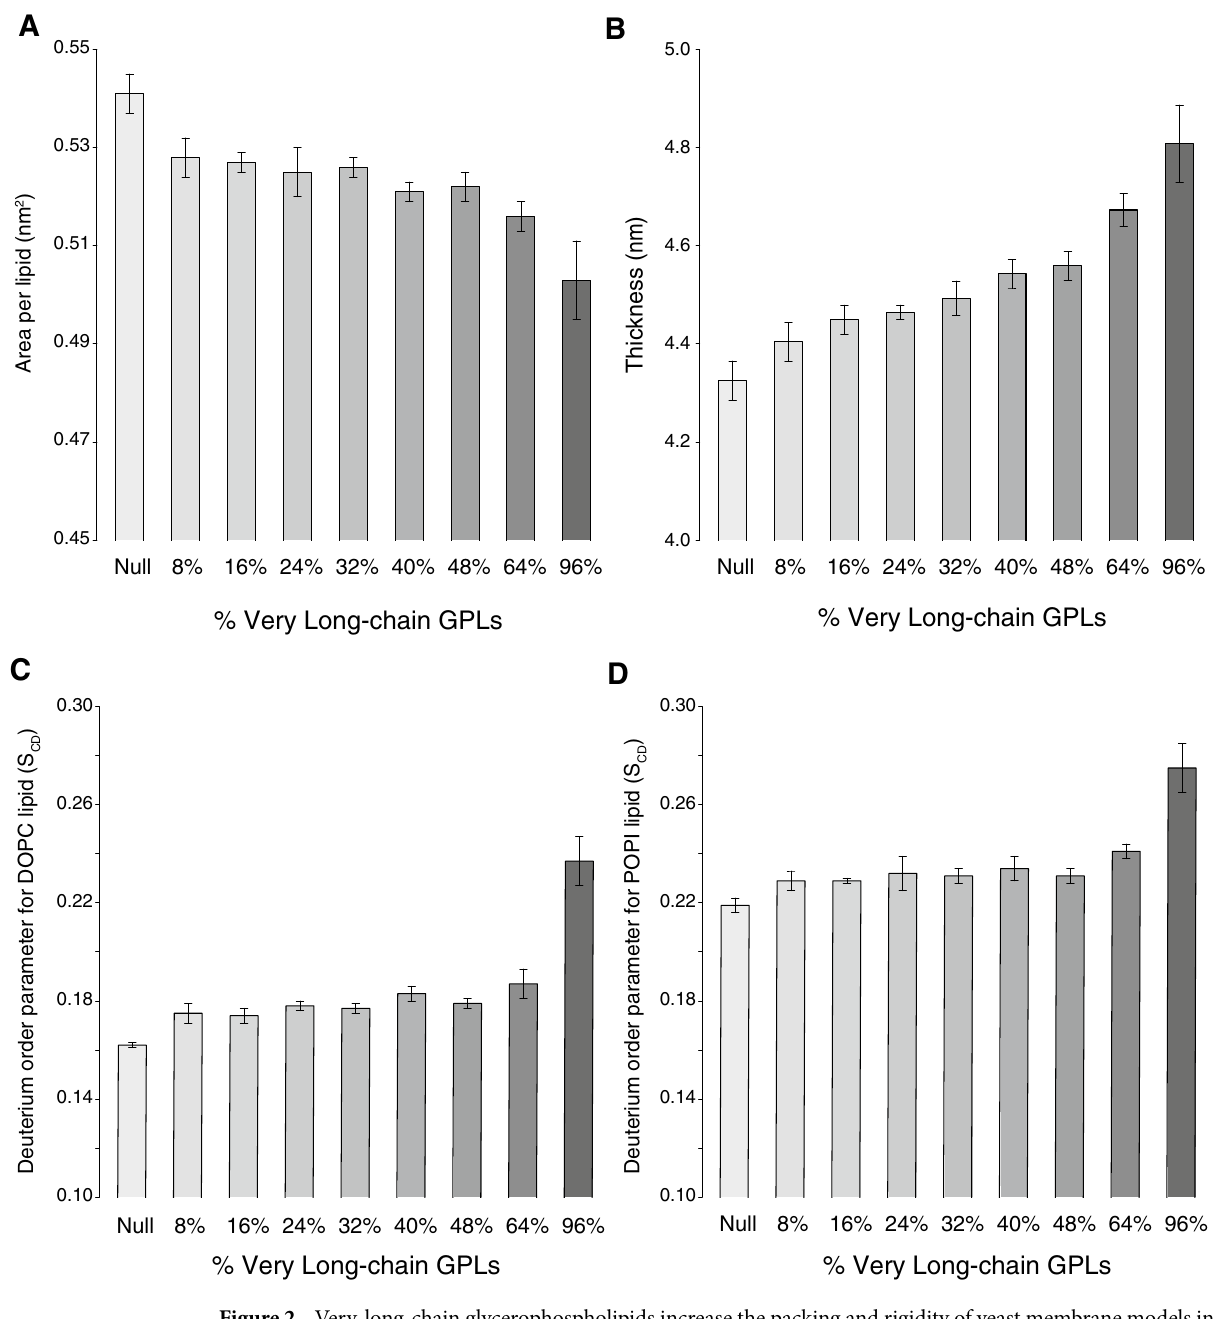
Figure 2. Very-long-chain glycerophospholipids increase the packing and rigidity of yeast membrane models in a concentration-dependent manner. Mean values and associated standard deviations of the structural properties of the membranes investigated in this study: ( A ) the area per lipid (APL), ( B ) the membrane thickness (MT) and ( C , D ) the deuterium order parameter (S CD ) of the sn1 acyl chains of DOPC and POPI. Simulations were performed for a membrane system with no very-long-chain GPLs (indicated as Null) and for membrane systems with increasing concentrations of very-long-chain GPLs from 8 to 96%. The very-long-chain GPLs were introduced using a 4:2:1 ratio replacing DOPC and POPI molecules The average values were calculated using only three replicates per system to have comparable results. DOPC 1,2 ‐ dioleoyl ‐ sn ‐ glycerol ‐ 3 ‐ phosphocholine; GPL glycerophospholipid, POPI 1 ‐ palmitoyl ‐ 2 ‐ oleoyl ‐ sn ‐ glycerol ‐ 3 ‐ phospho ‐ (1 ′ ‐